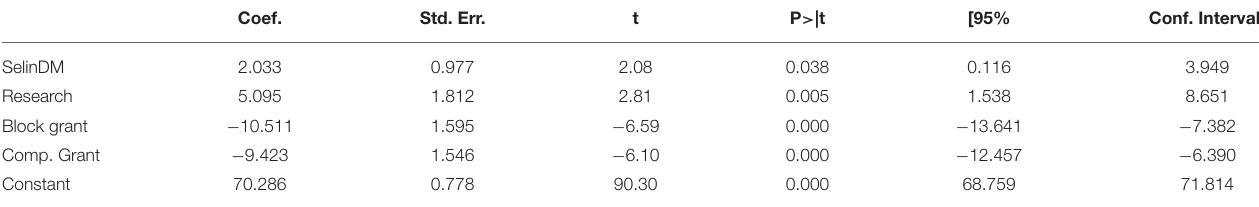
TABLE 5 | PART scores (OLS) by Selin’s decision maker, model 2. Coef. Std. Err.